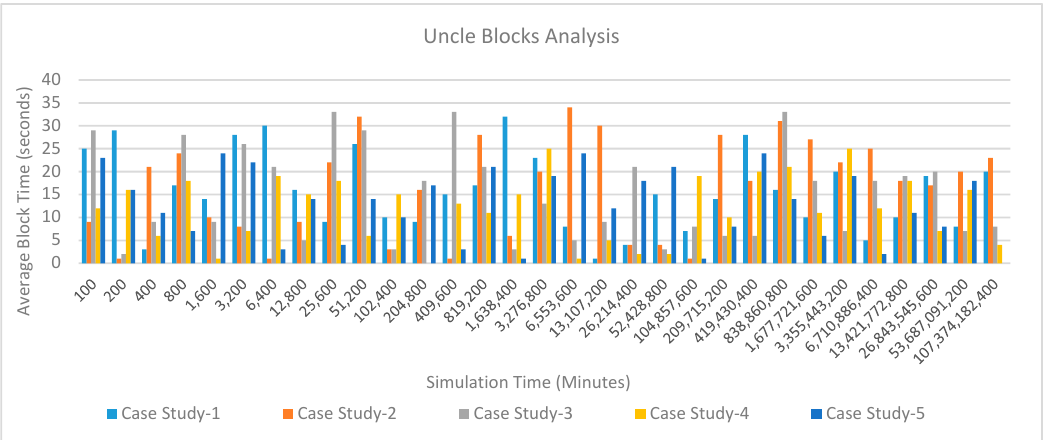
Figure 28. Average block size variations over simulation time for five case-studies.